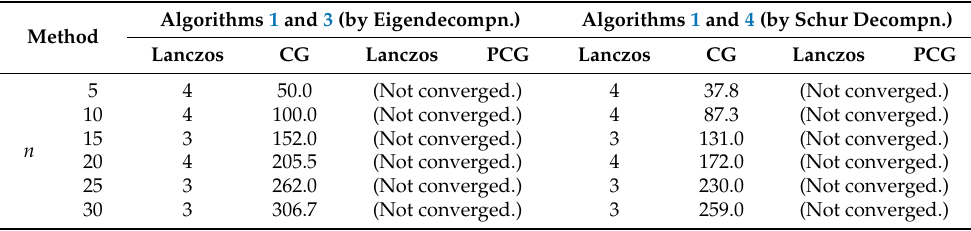
Table 5. Number of iterations of the Lanczos method and the average of numbers of iterations of the CG/PCG method in the case of the 5-th max. singular value of slightly symmetric matrix T with a = c = 1 and b = 0.1 in (9) for the shift (8). Algorithms 1 and 3 (by Eigendecompn.) Algorithms 1 and 4 (by Schur Method